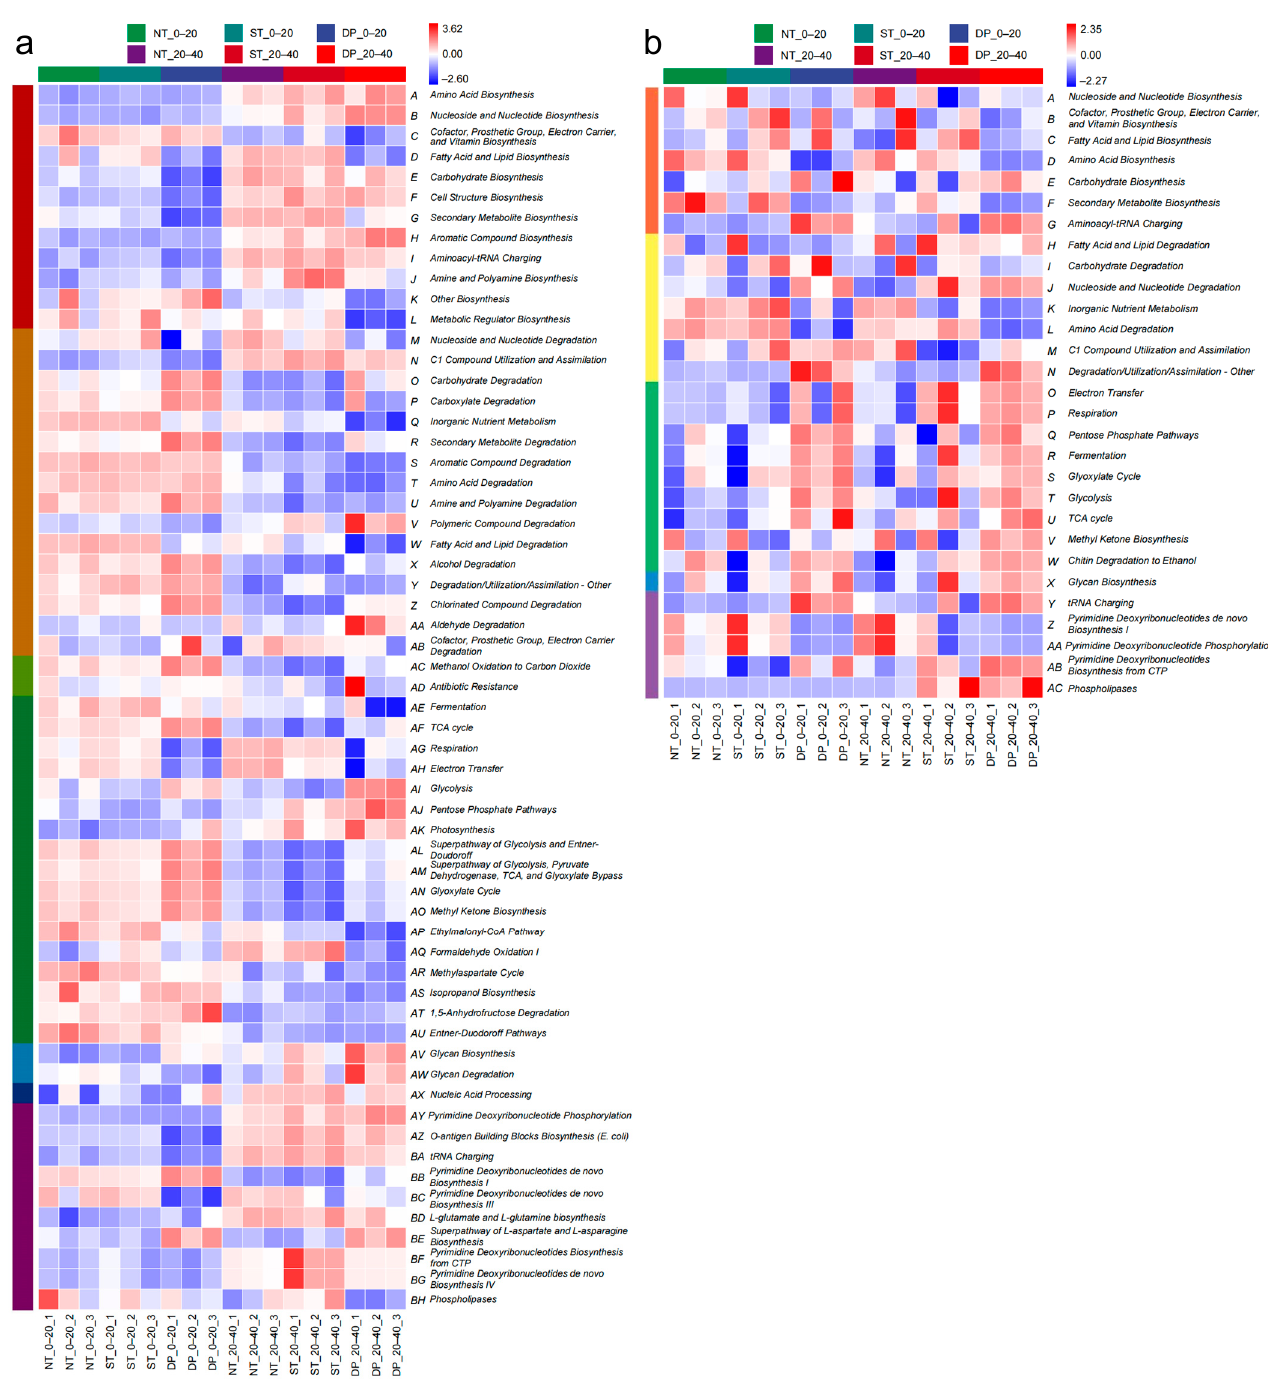
Figure 5. The interactive heatmap shows metabolic functional pathways at level 2 of soil bacterial ( a ) and fungal ( b ) communities affected by tillage and soil layer as predicted based on the MetaCyc database. Among the metabolic functions of bacterial communities, the level 1 metabolic pathways are as follows: Biosynthesis: A-L; Degradation/Utilization/Assimilation: M-AB; Detoxification: AC-AD; Generation of Precursor Metabolite and Energy: AE-AU; Glycan Pathways: AV-AW; Macromolecule Modification: AX; Metabolic Clusters: AY-BH. Among the metabolic functions of fungal communities, the level 1 metabolic pathways are as follows: Biosynthesis: A-G; Degrada- tion/Utilization/Assimilation: H-N; Generation of Precursor Metabolite and Energy: O-W; Glycan Pathways: X; Metabolic Clusters: Y-AC. NT: no-tillage; ST: subsoiling tillage; DP: deep